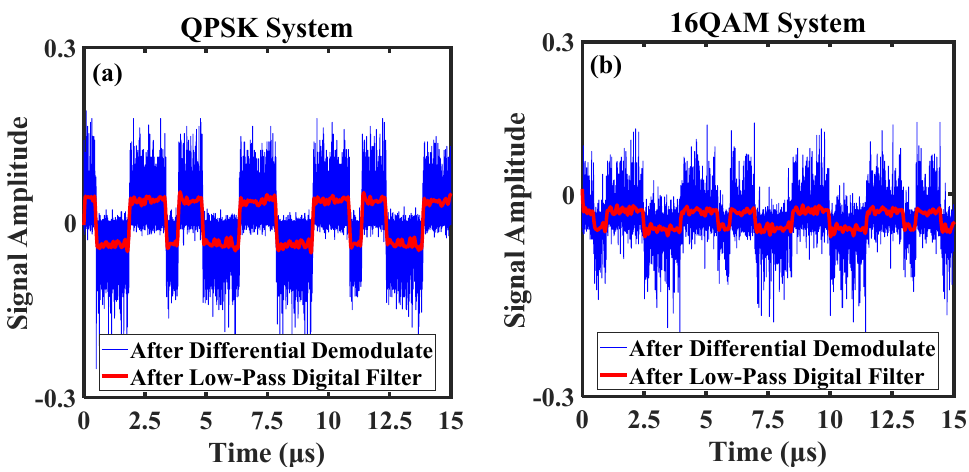
Figure 10. The demodulated waveform of optical labels in ( a ) QPSK and ( b ) 16QAM systems.